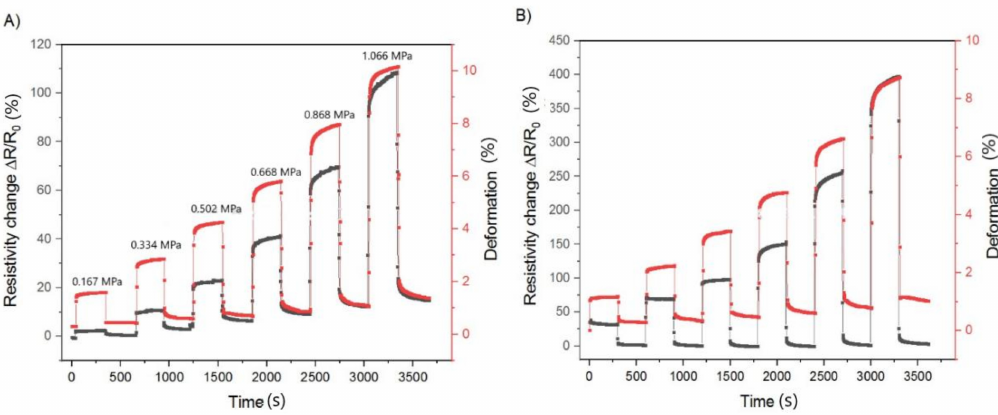
Figure 5. The comparison of the relative resistance change vs. the deformation for the MWCNTs (pure) ( A ) and MWCNTs (KMnO 4 ) ( B ) sensor in six extension / relaxation cycles induced by the tensile stress (from 0.167 to 1.066 MPa). The tensile stresses are the same for both measurements. The deformation is denoted by red circles, the relative resistance changes by black